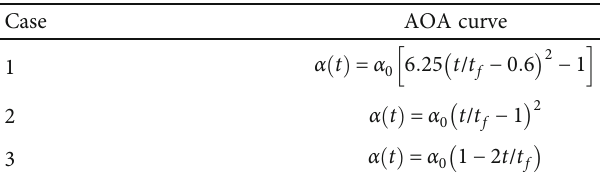
Table 2: Angle of Attack